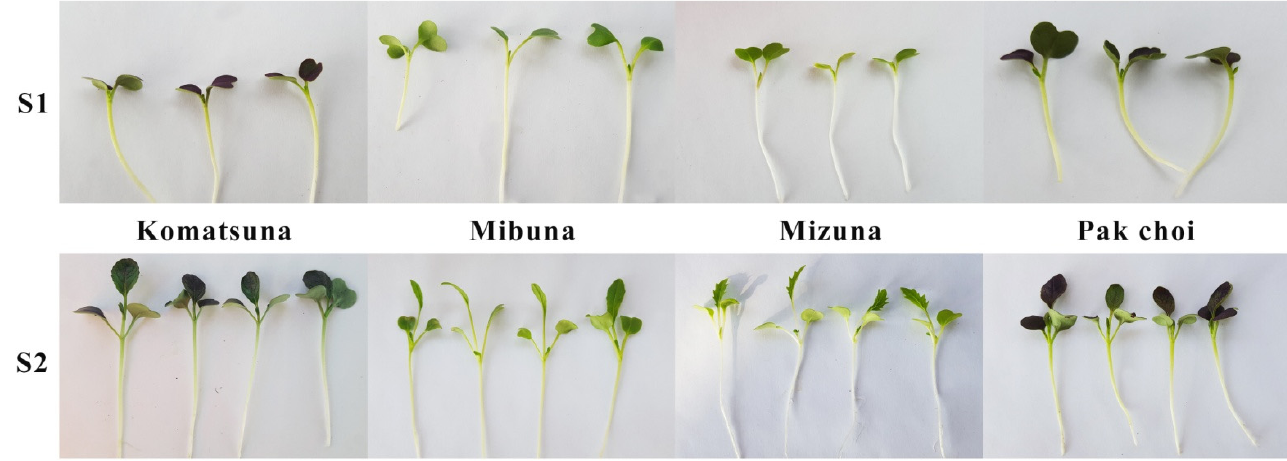
Figure 1. Phenological stages for harvesting four Brassica rapa L. genotypes (Komatsuna, Mibuna, Mizuna, Pak Choi grown under controlled conditions: S1-appearance of the first true leaf; S2-appearance of the second true leaf).